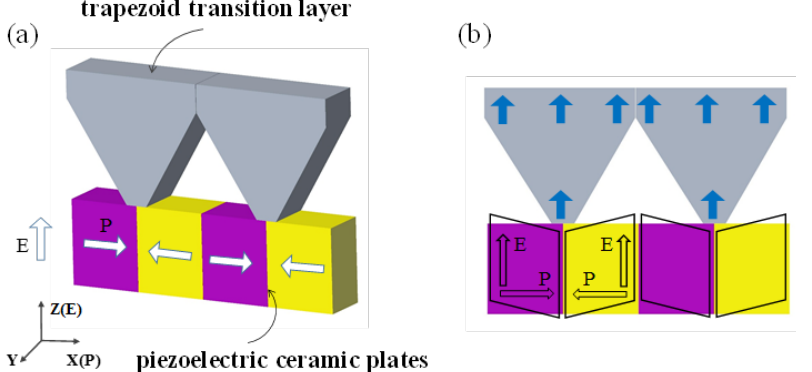
Figure 1. Piezoelectric oscillator based on shear vibration mode. ( a ) Structure diagram; ( b ) vibration form of the oscillator.